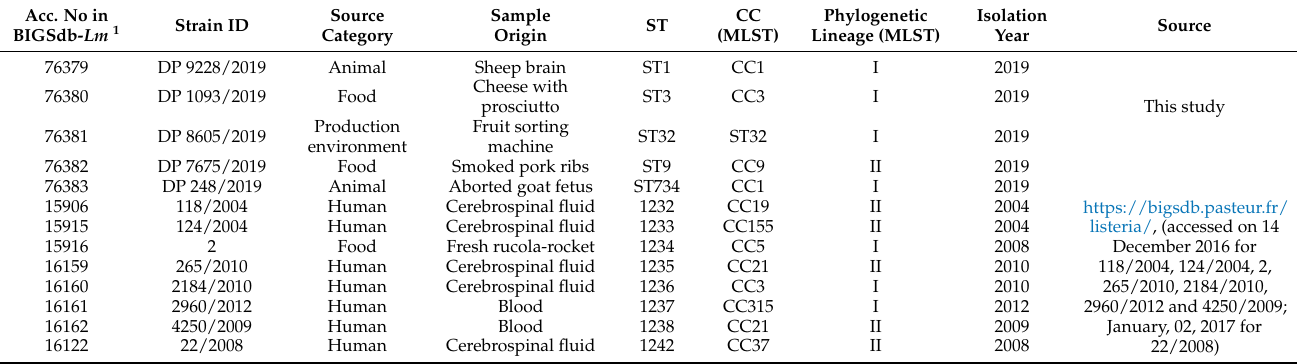
Table 1. MLST characteristics of L. monocytogenes strains isolated in the Republic of Serbia in 2004–2019. Acc. No in BIGSdb- Lm